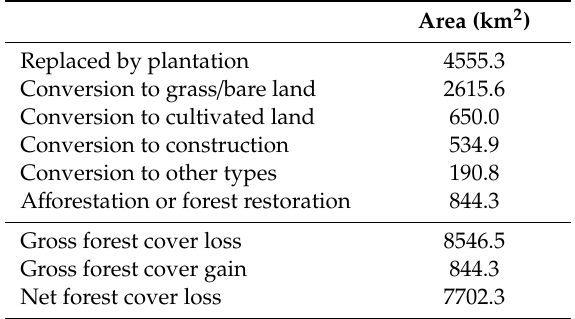
Table 5. Natural forest cover and change from 1988 to